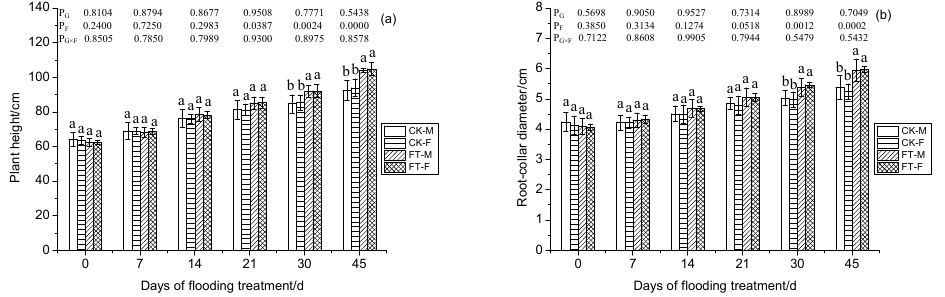
Figure 1. The plant height ( a ) and root collar diameter ( b ) of male vs. female Salix viminalis plants at di ff erent times of flooding treatment. Note: The data are the mean ± standard deviation (SD) from five replicates. Different small letters indicate significant differences between treatments at the same time point according to Duncan tests ( p < 0.05). CK, control; FT, flooding treatment; M, male; F, female; P G , gender effect; P F , flooding effect; P G×F , gender and flooding interaction effect.